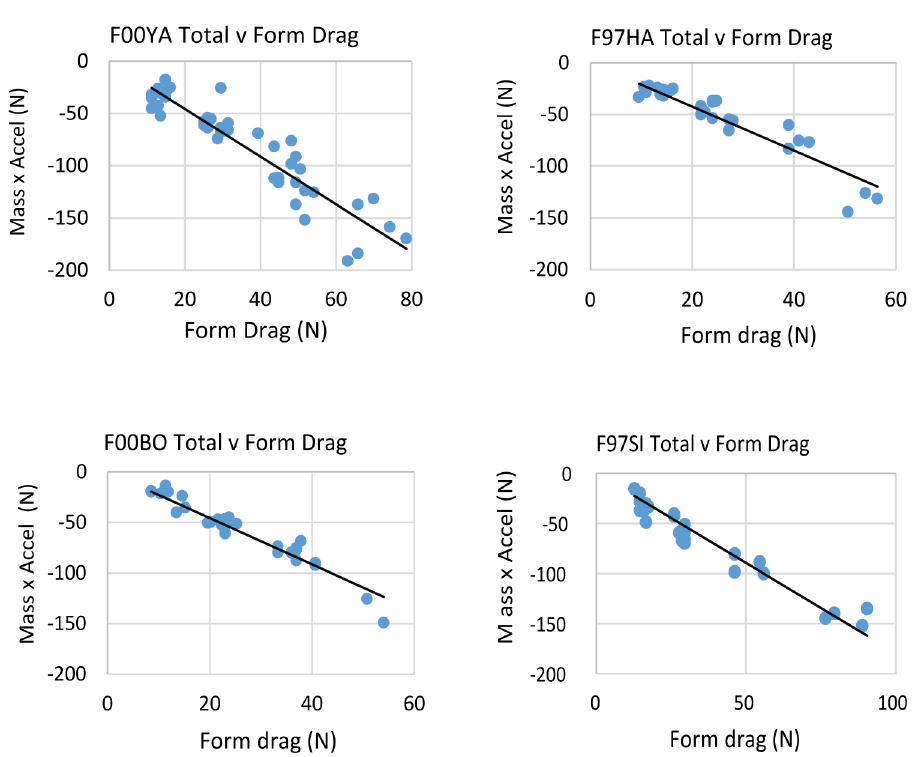
Fig 13. Total drag during the glide phase (Eq 5), versus form drag. The latter is represented by the U boat2 term in Eq